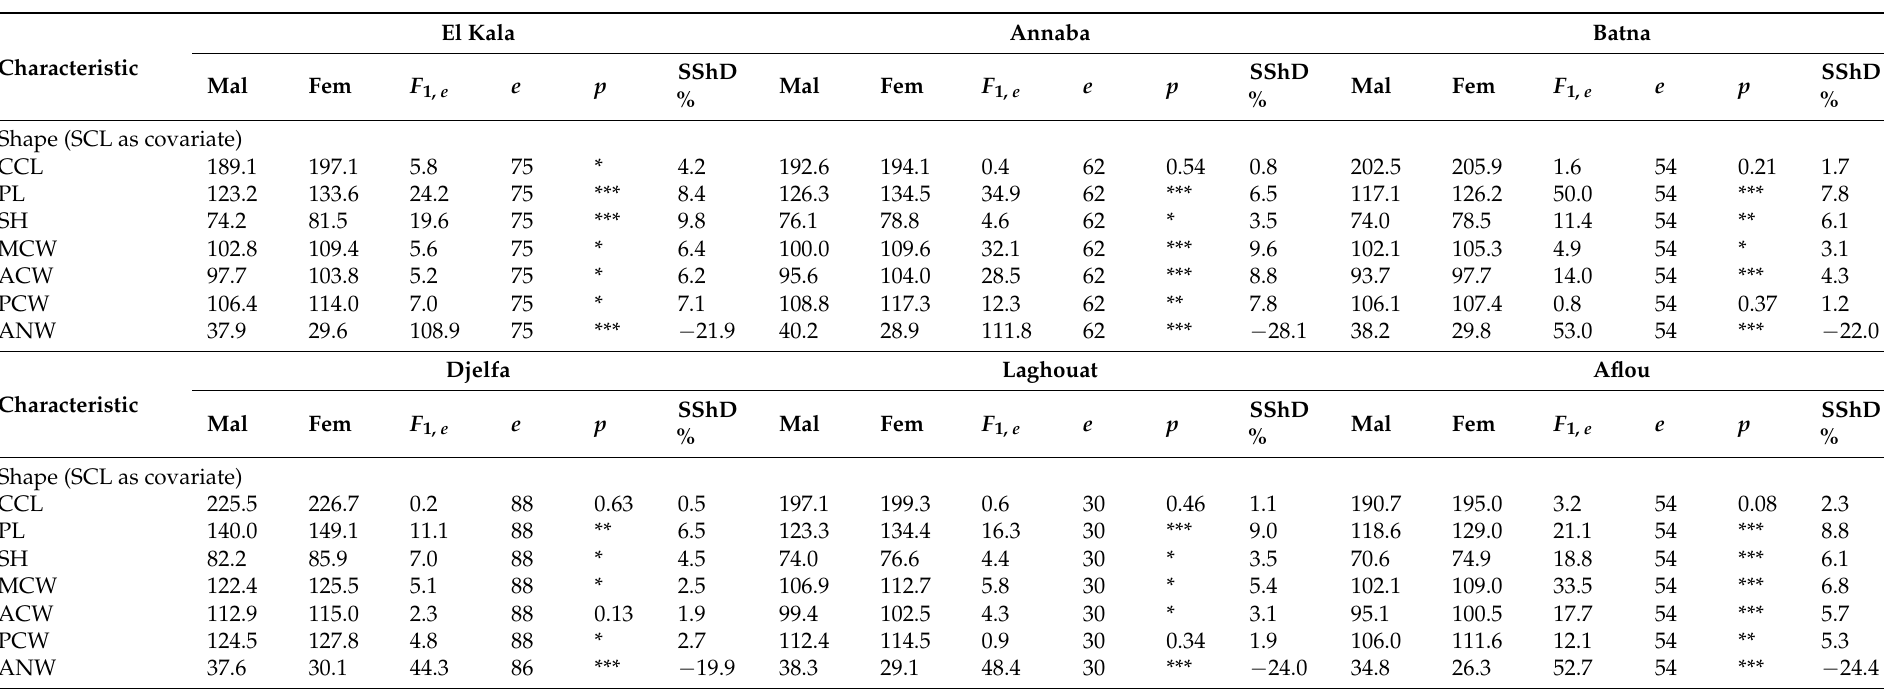
Table A2. Sexual dimorphism of shell shape among adults of Algerian T. graeca populations. Abbreviated characteristics are explained in the Materials and Methods section. Here, the results are taken as adjusted means (in mm); One-way ANCOVA by sex with SCL as the covariate; e —error degrees of freedom; sample size n = e + 3; Mal—males; Fem—females. p < 0.05 (*); p < 0.01 (**); p < 0.001 (***); SShD%—the percentage of sexual shell shape dimorphism is calculated as 100 ((F −